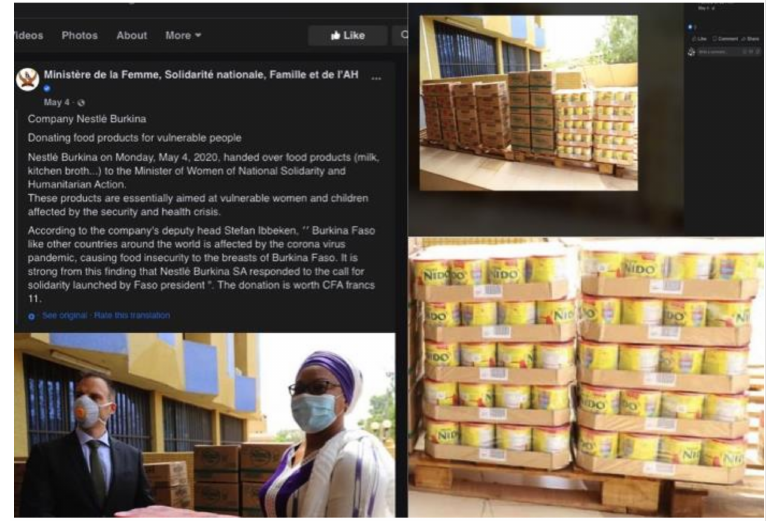
Figure 6. Screenshots of Nestl é ’s donations to the Ministry of Women, National Solidarity and Family, and Ministry of Humanitarian Action in Burkina Faso taken from